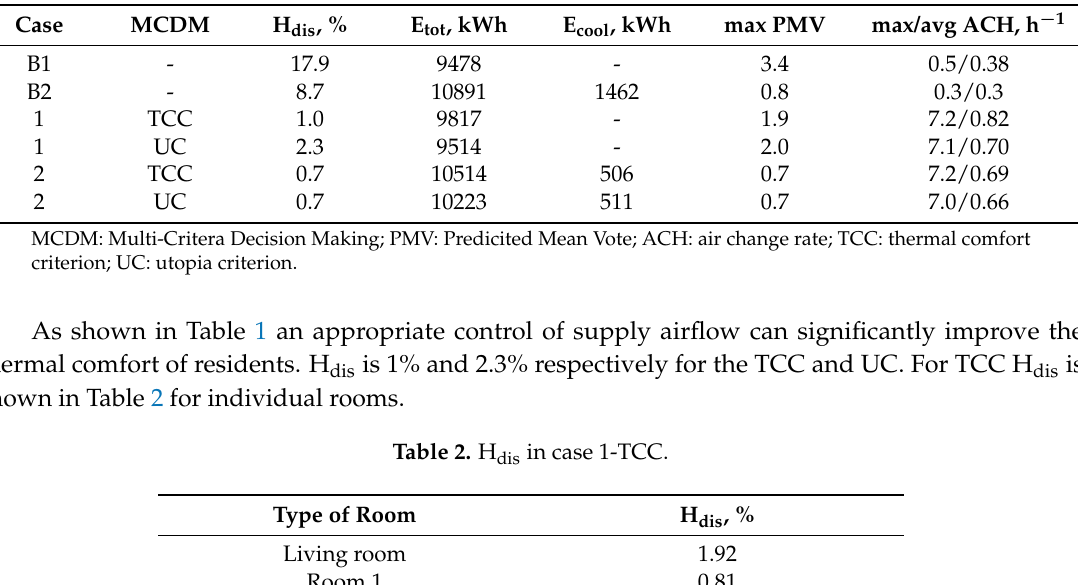
Figure 10. Annual variation and frequency distribution of PMV for room 1 in case 1. Table 1. Results for all analysed cases.